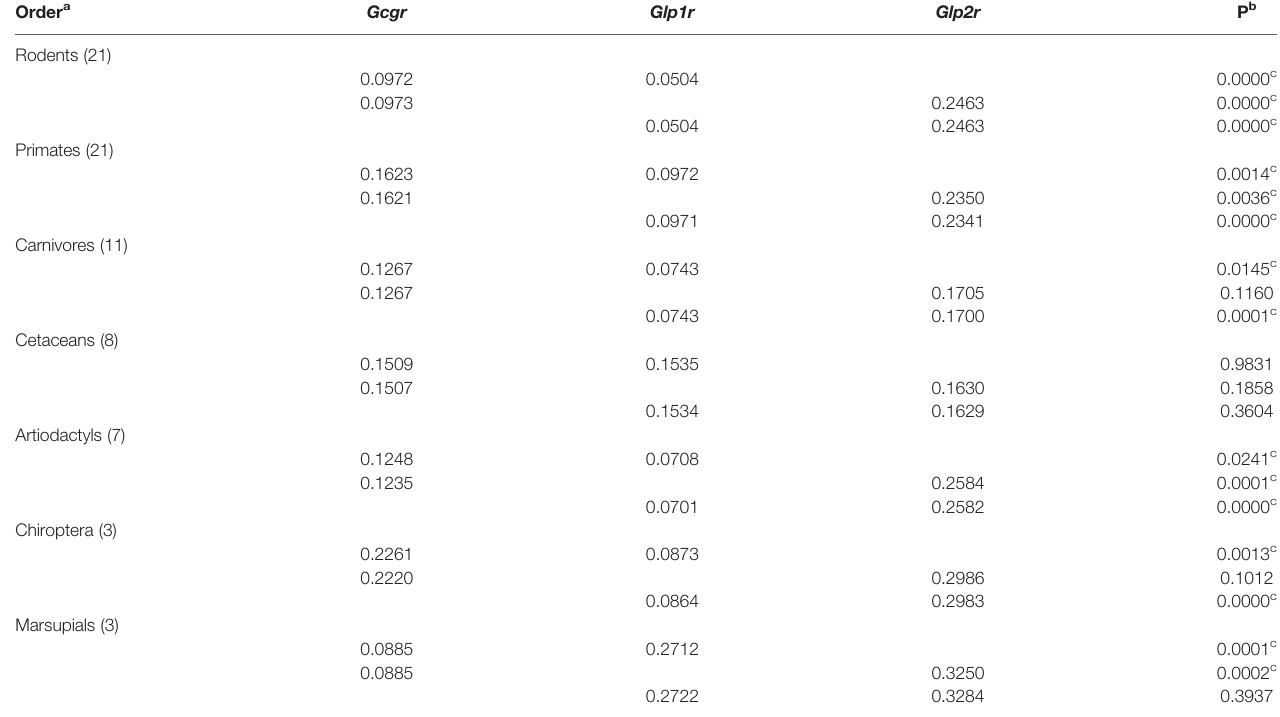
TABLE 3 | Selective constraints (d N /d S ) acting on Gcgr , Glp1r , and Glp2 in different mammalian orders. Order